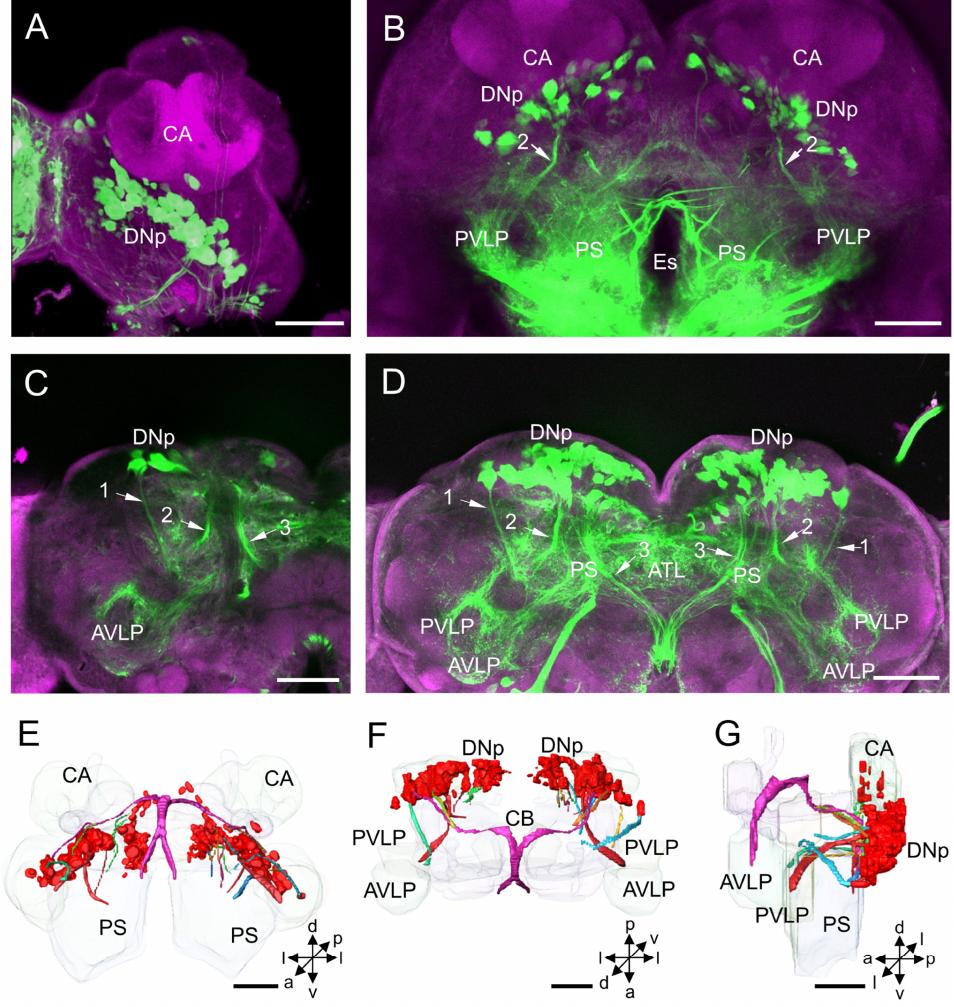
Figure 5. Distribution and projection patterns of DNp neurons in the brain: ( A , B ) projection views of confocal stack images of DNp somata and primary neurites (arrows, No. 1–3); ( C , D ) projection views of confocal stack images showing DNp somata and primary neurites (arrows); and ( E – G ) the anterior, dorsal, and lateral views of the three-dimensional reconstruction showing DNp somata and primary neurites in the brain. AVLP, anterior ventrolateral protocerebrum; CA, calyx; CB, central body; Es,